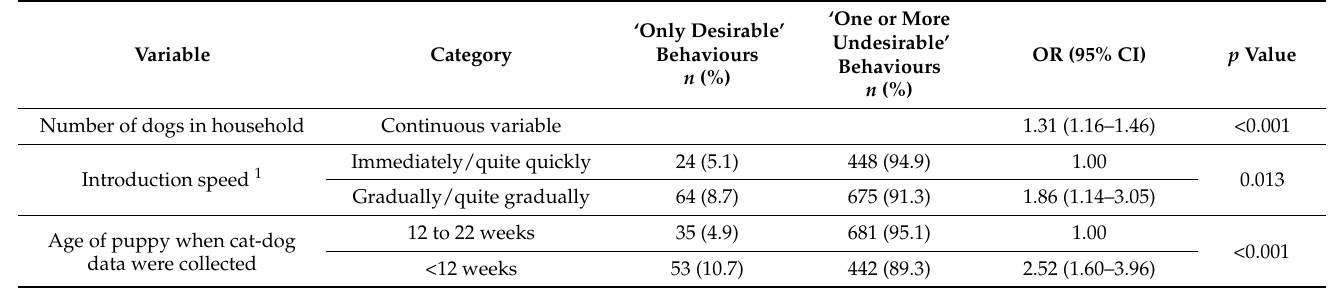
Table 5. Multivariable logistic regression model for ‘only desirable’ behaviour from puppies following introduction to existing household cat(s) ( n =